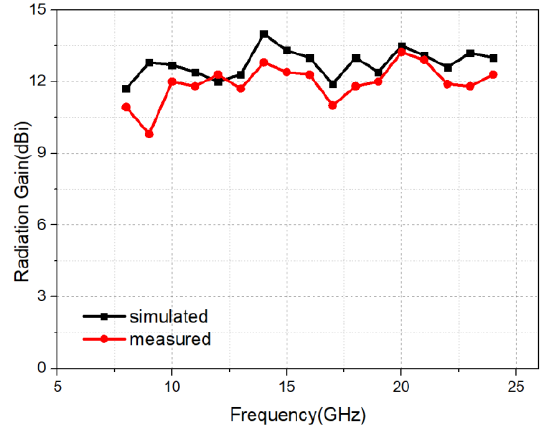
Figure 13. The radiation gain of the proposed SSPP LWA.